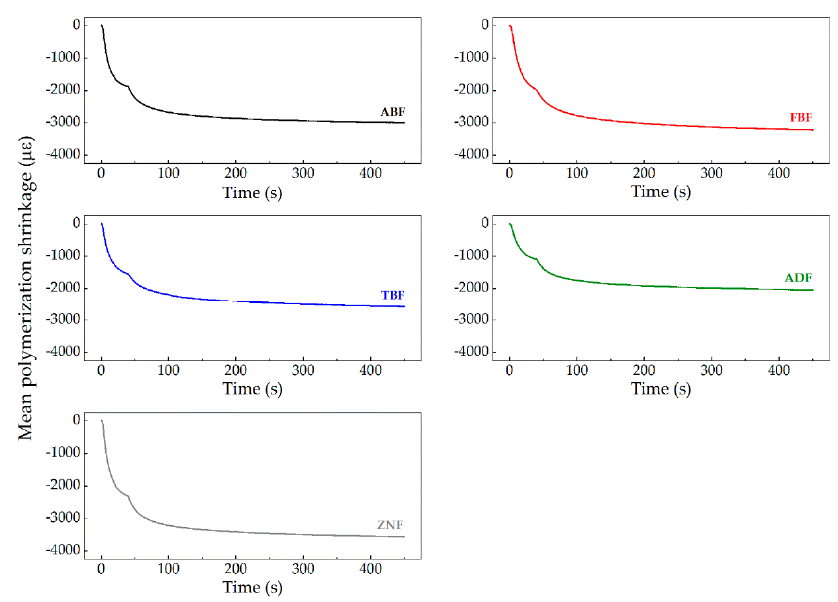
Figure 3. Graphic representation of the mean polymerization shrinkage of the RBCs over time.